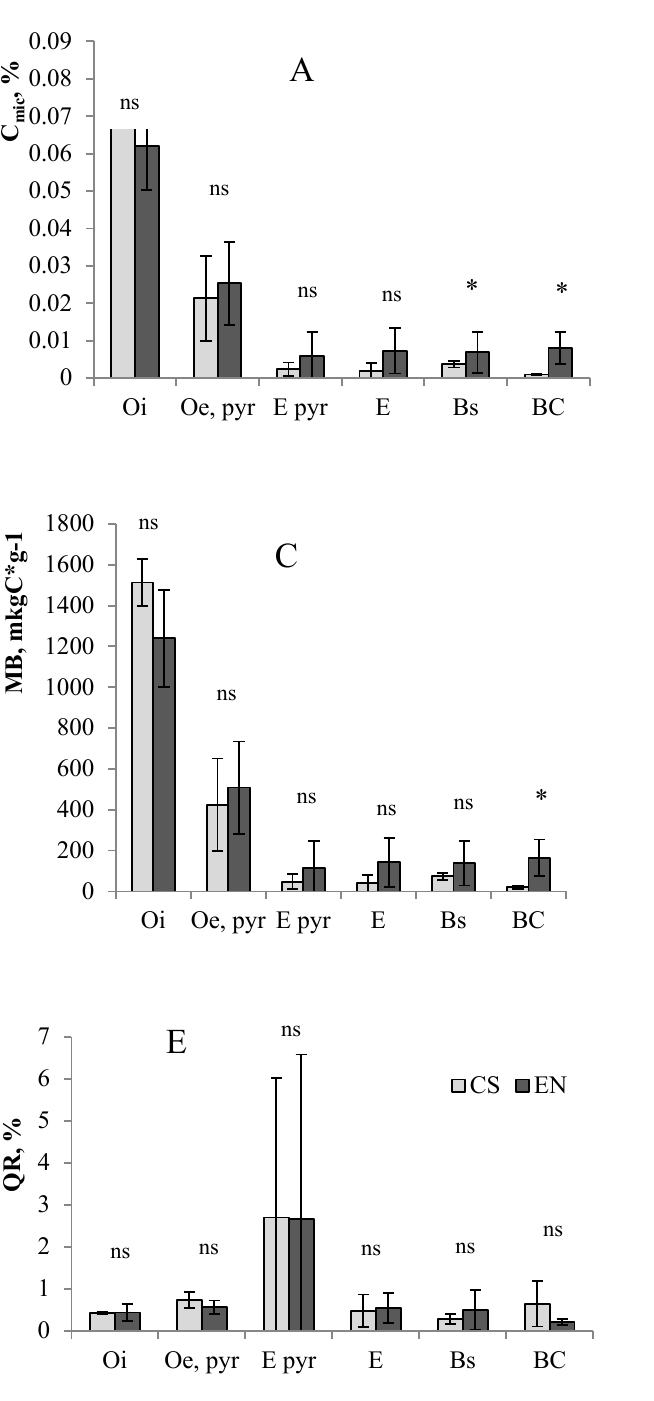
Figure 6. Values of microbial carbon, % ( A ), part of C mic at C tot. , % ( B ), microbial biomass (MB) ( C ), and basal respiration (BR) ( D ), and microbial metabolic coefficient (QR) ( E ), ( n = 3, the error bars are the standard errors). Abbreviation: CS—Central Siberia, EN—European North. *—indicate significant differences between EN and CS, ns—differences between EN and CS are not significant at p < 0.05.